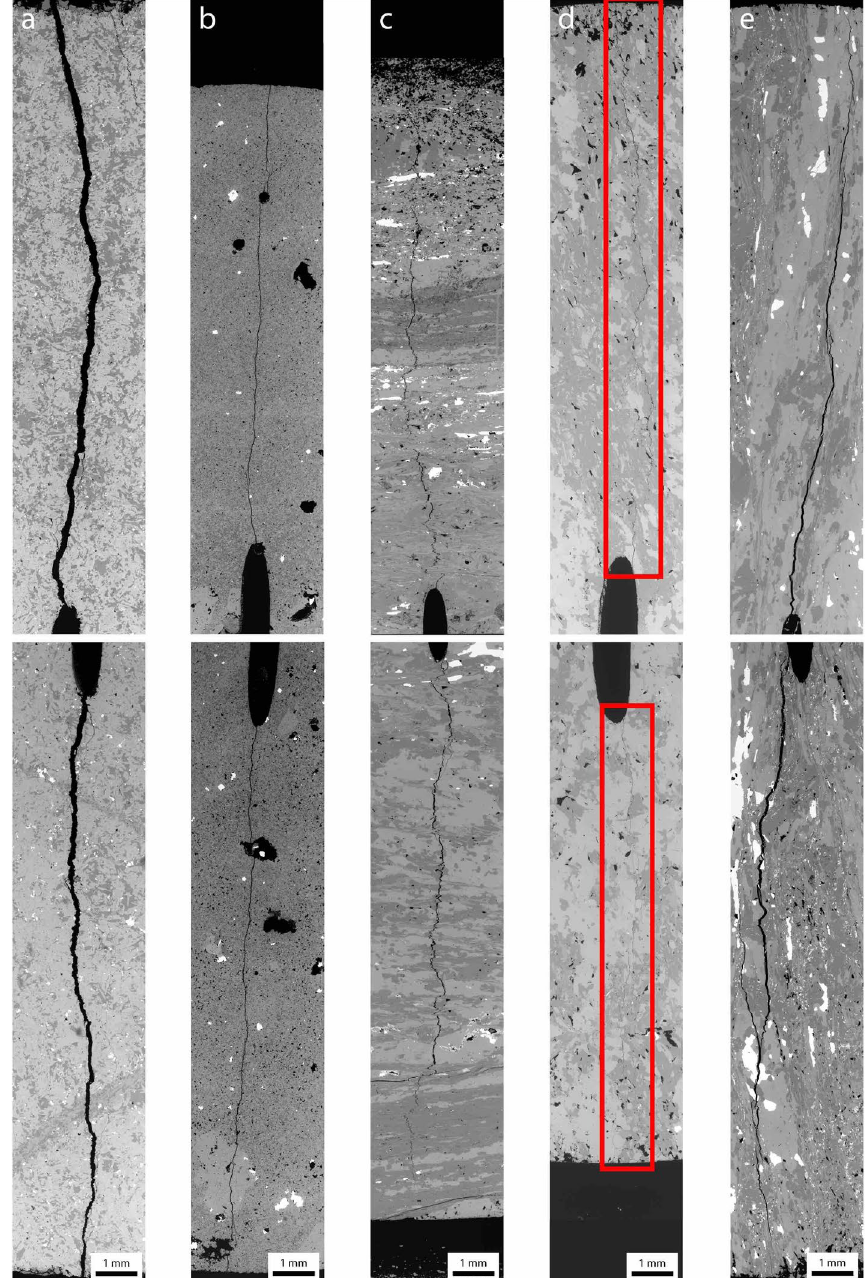
Figure 7. BSE images displaying the entire length of the fracture for each of the five sample groups: ( a ) amphibolite (A14), ( b ) rhyolite (R08), ( c ) schist–arrester (SA08), ( d ) schist–divider (SD04), ( e ) schist–short transverse (SFS10). Outline indicates region of